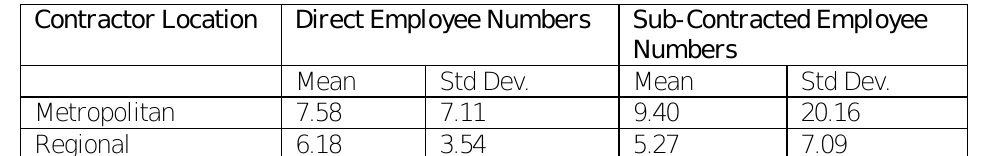
Contractor Location